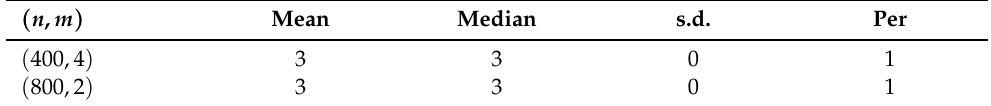
Table 1. The sample mean, median, and standard error (s.d.) of ˆ M and the empirical percentage (per) of ˆ M equal to the true number of subgroups based on 100 replications in Example 1.